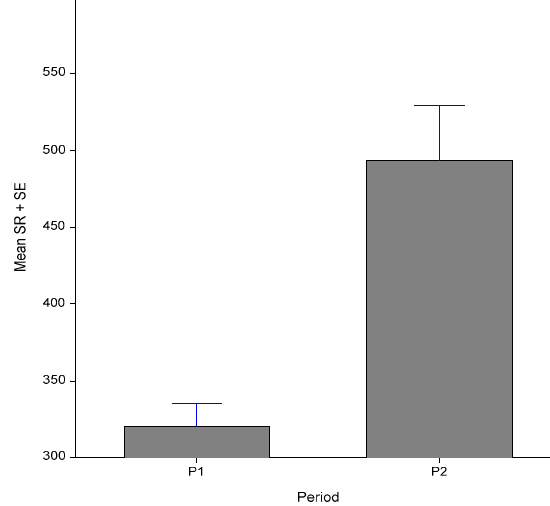
Figure 3. Mean values and standard error of means of sweating rates in P1 and P2.